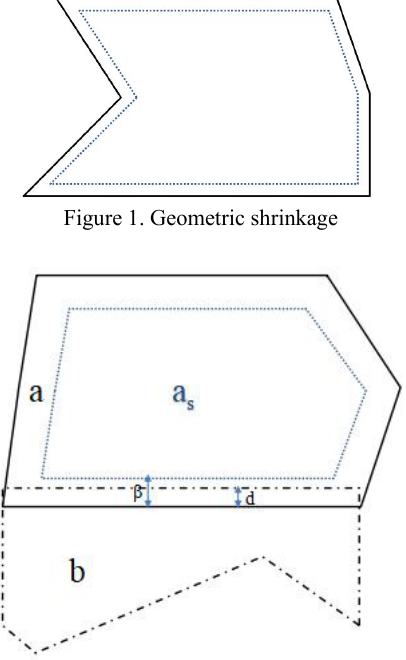
Figure 2. Boundary crossing caused by